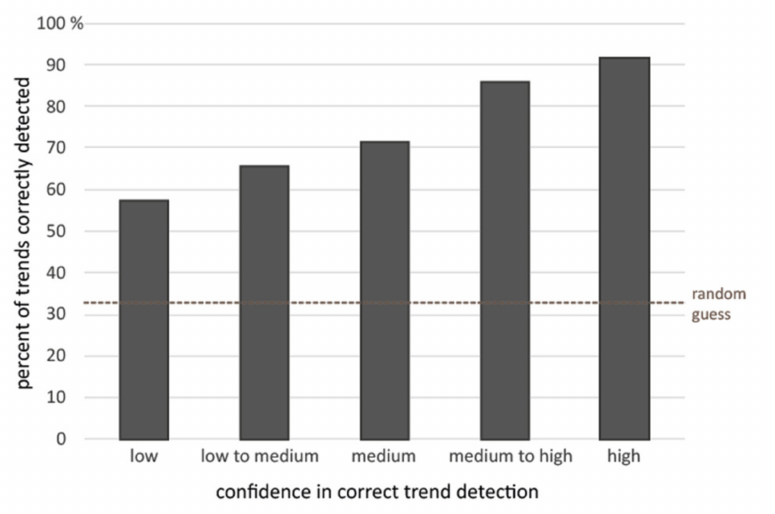
Figure 11. Hit rates for different levels of confidence in correct trend